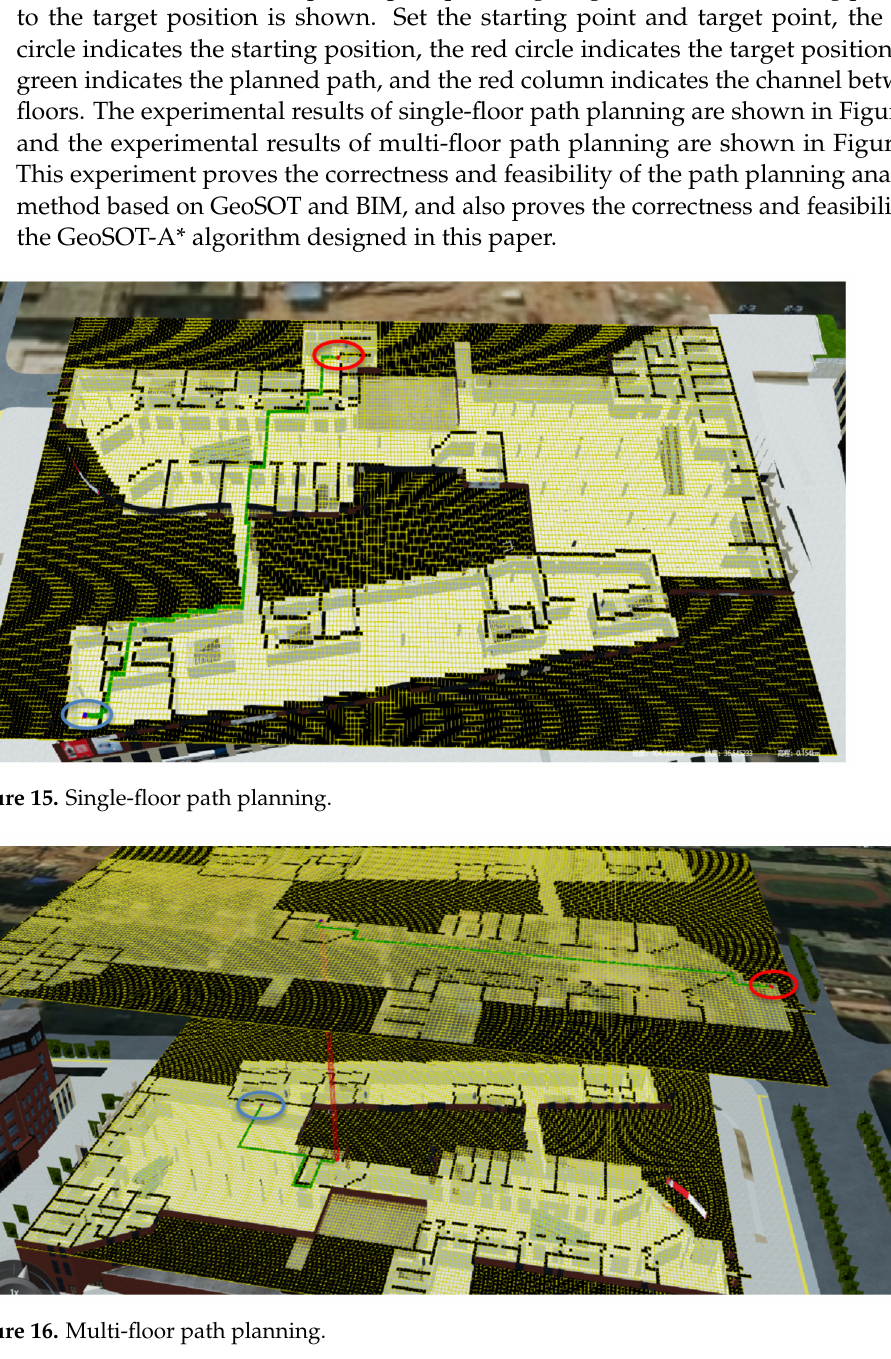
Figure 16. Multi-floor path